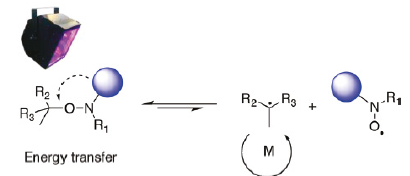
Figure4. NMP2concept. Reprintedwithpermissionfrom(Guillaneuf, Y.; Bertin, D.; Gigmes, D.; Versace, Figure 4. NMP2 concept. Reprinted with permission from (Guillaneuf, Y.; Bertin, D.; Gigmes, D.; D.-L.; Lalev é e, J.; Fouassier, J.P. Toward Nitroxide-Mediated Photopolymerization. Macromolecules 2010 , Versace, D.-L.; Lalevée, J.; Fouassier, J.P. Toward Nitroxide-Mediated Photopolymerization.